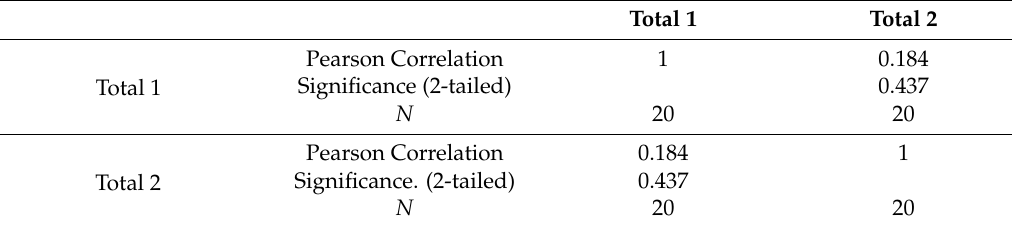
Table 9. The Pearson’s correlation test